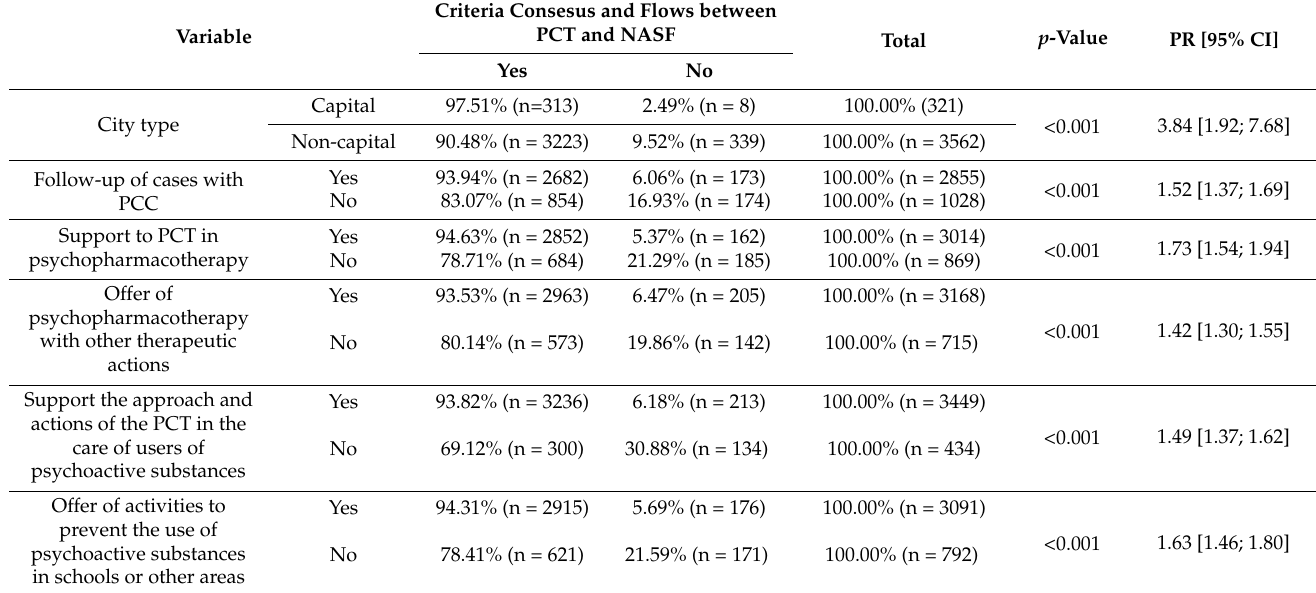
Table 2. Bivariate associations of agreement criteria and flows between primary care teams (PCT) and family health support center (NASF) for mental health care in PHC and specialized services, considering the difference for capital and non-capital cities of Brazil